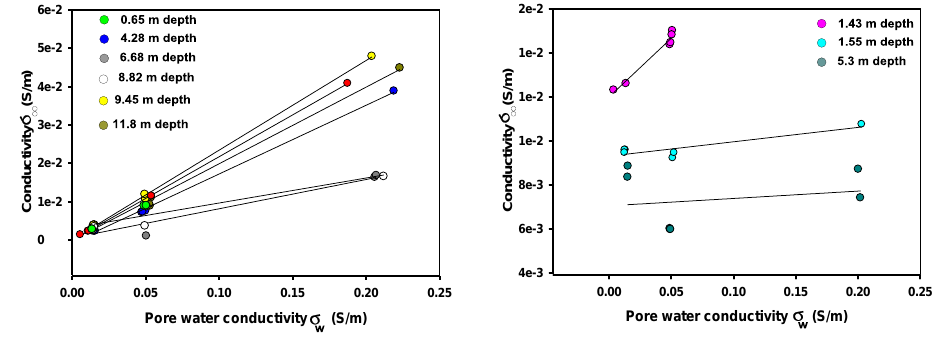
Fig. 7. High-frequency conductivity ( σ ∞ ) versus pore water conductivity for core samples at different depths.